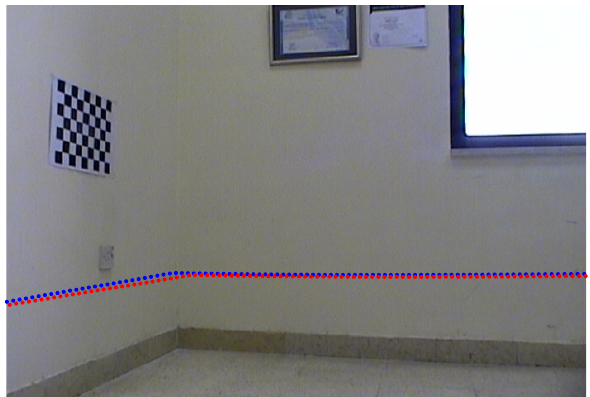
Figure 15. Extra step verification. The blue colored points (upper points) are projection of lidar points onto a test image using the estimated calibration result from configuration 2. The red colored points (lower points) are projection of the same lidar points but using the product of the extrinsic calibration result from configuration 1 and the estimated stereo transformation between the left camera to the PTZ